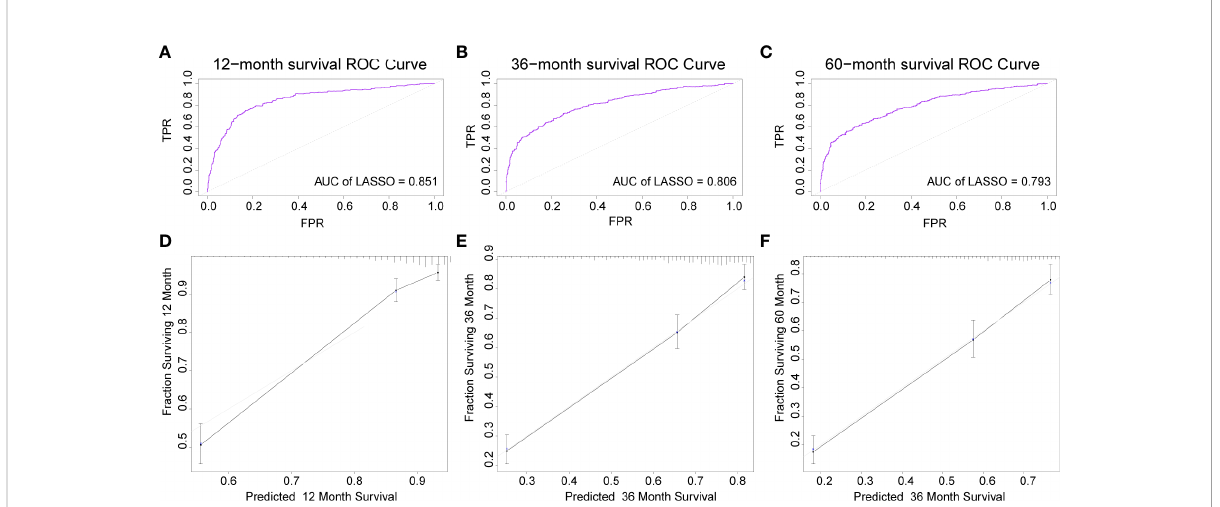
FIGURE 6 The AUC and calibration curves of DL survival Cox model at 1-, 3-, 5-years in the training set. (A – C) , the AUC of the model at 1-, 3-, 5-years. (D – F) , the calibration curves of model at 1-, 3-, 5-years. AUC, area under the curve; DL, deep